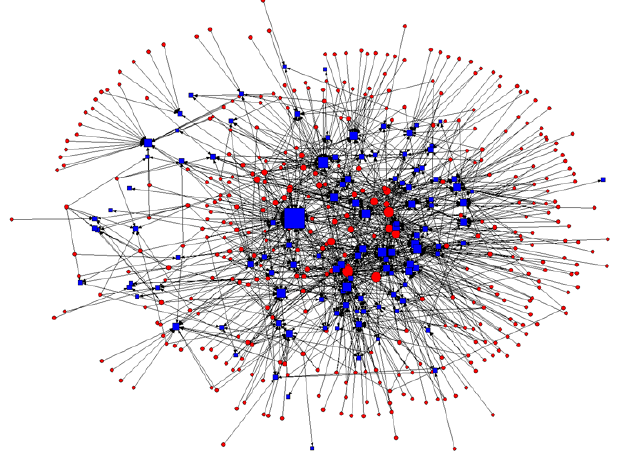
Fig. 2 . Bipartite network for the Bay Area ecology of